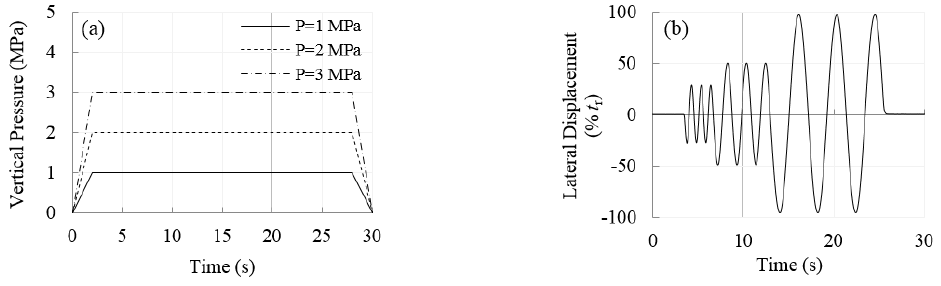
Figure 5. Input loadings in cyclic tests: ( a ) variation of vertical pressure over time; ( b ) cyclic displacements (25% t r to 100% t r ).